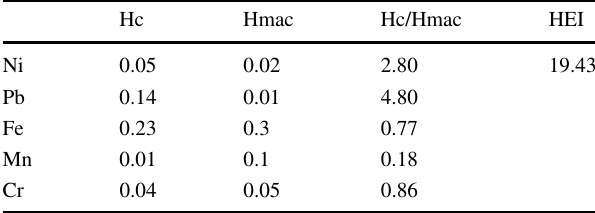
Table 4 Heavy metal evaluation index for groundwater at site 2